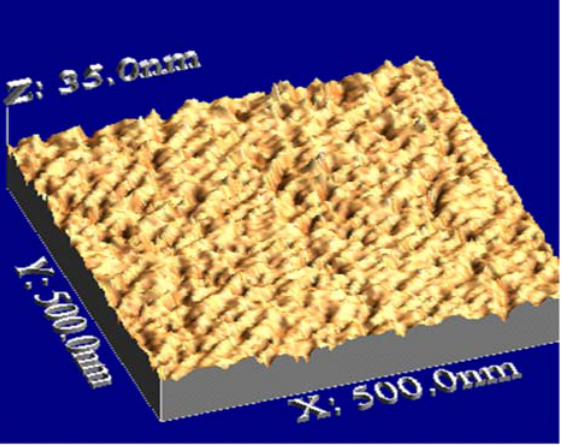
Fig. 9 AFM images of silica (ETMS) hybrids containing 15 mol % calcium alginate. of enzyme activity, especially upon